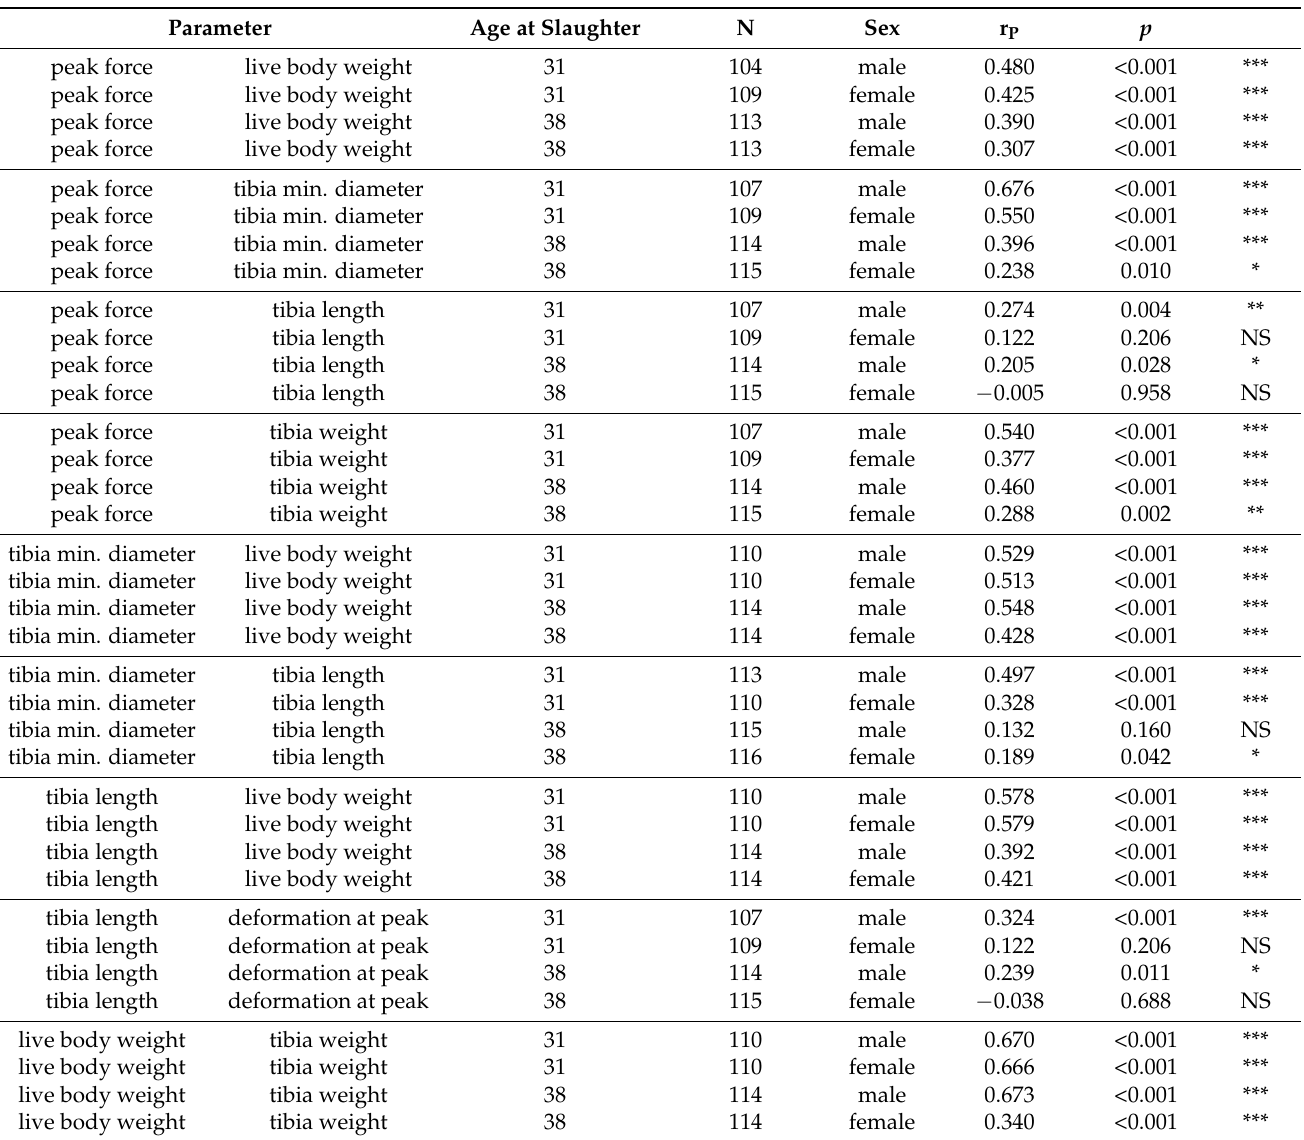
Table 5. Pearson correlation coefficients (r P ) for the parameters live body weight, tibiotarsus weight, length, minimum diameter, peak force, deformation at peak and each sex per age of